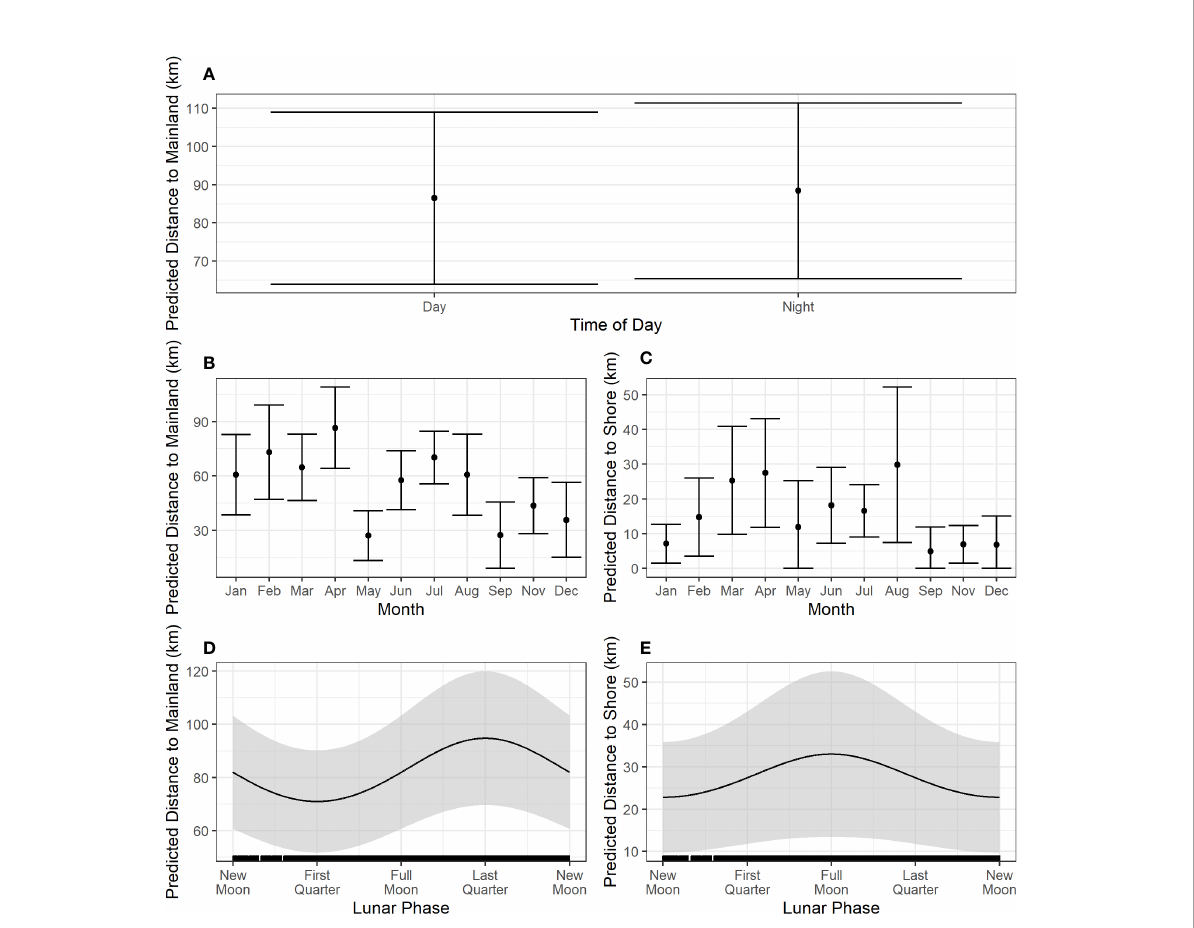
FIGURE 4 Prediction plots from the fi tted models for distance to mainland (A, B, D) and distance to shore (C, E) . Solid black lines/dots represent mean predicted values with shaded areas/error bars representing the 95% CI. Hash marks along the x-axis shows the spread of data. For the creation of these plots, values for other predictors in each model were set at the median or modal value as follows: time of day = day, month = April, sine of lunar phase = -0.370, cosine of lunar phase = -0.010.